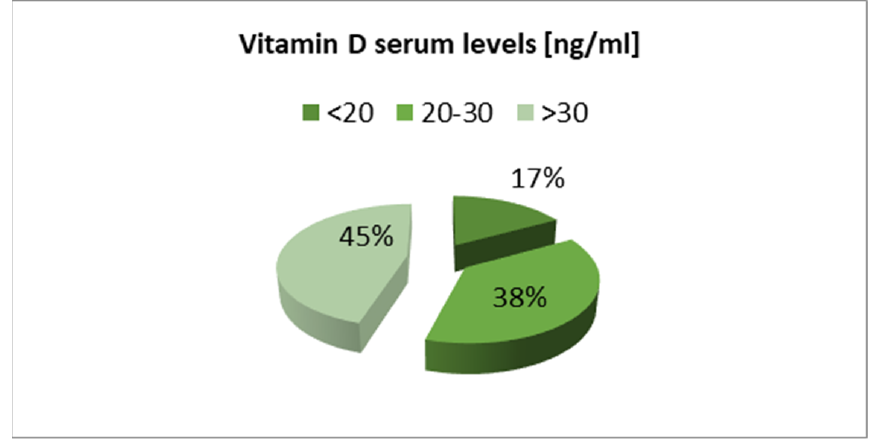
Figure 3. Vitamin D serum levels in children during the COVID-19 pandemic (Group 2).